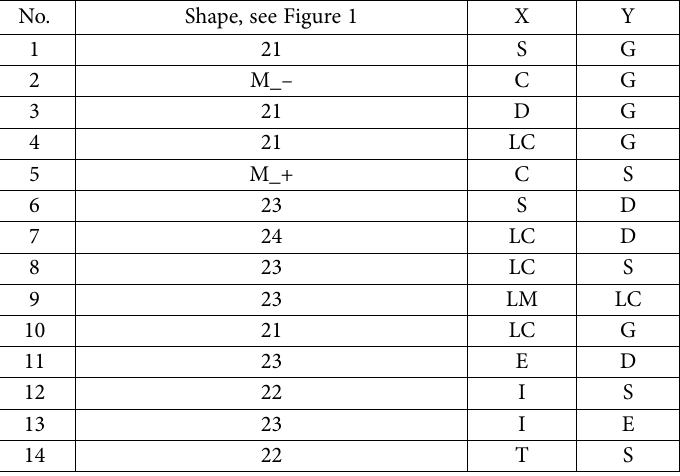
Table 5. Equationless model under study (source: elaborated by the authors) No. Shape, see Figure 1